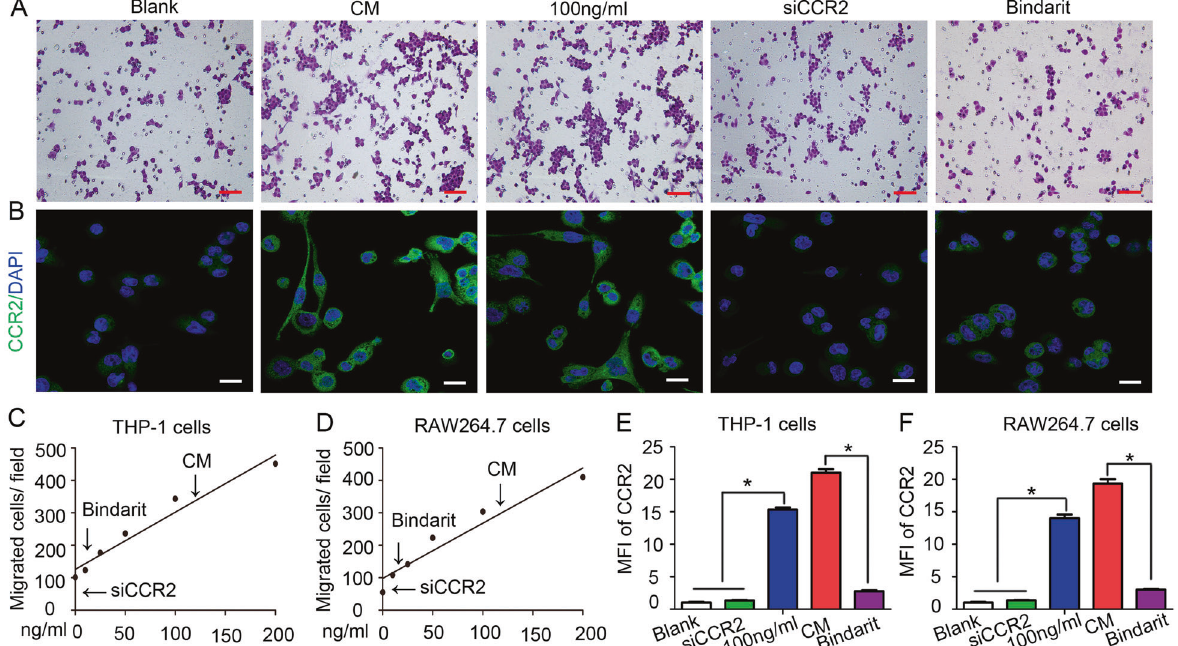
Fig. 4 CCL8-CCR2 interaction mediates TAM in fi ltration under hypoxic conditions. a Using a migration test, we identi fi ed that the migration effect of hypoxic cervical cancer cells on THP-1 cells was almost equivalent to that of 100 ng/ml CCL8. Bindarit (a CCL8 synthesis inhibitor) and siCCR2 signi fi cantly impaired the directional migration of THP-1 cells. Scale bar, 100 μ m. b Immuno fl uorescence staining revealed that the level of CCR2 expression was increased in THP-1 cells incubated with 100 ng/ml CCL8 and decreased in THP-1 cells treated with bindarit or siCCR2. Scale bar, 100 μ m. c Statistical analysis showing the number of migrated THP-1 cells. d Statistical analysis showing the number of migrated RAW264.7 cells. e Statistical analysis showing the fold change of the mean fl uorescence intensity (MFI) of CCR2 in THP-1 cells. f Statistical analysis showing the fold change of the MFI of CCR2 in RAW264.7